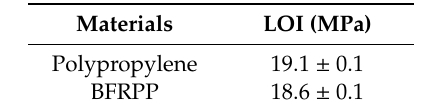
Table 4. LOI and UL-94 test for basalt fiber and polypropylene.